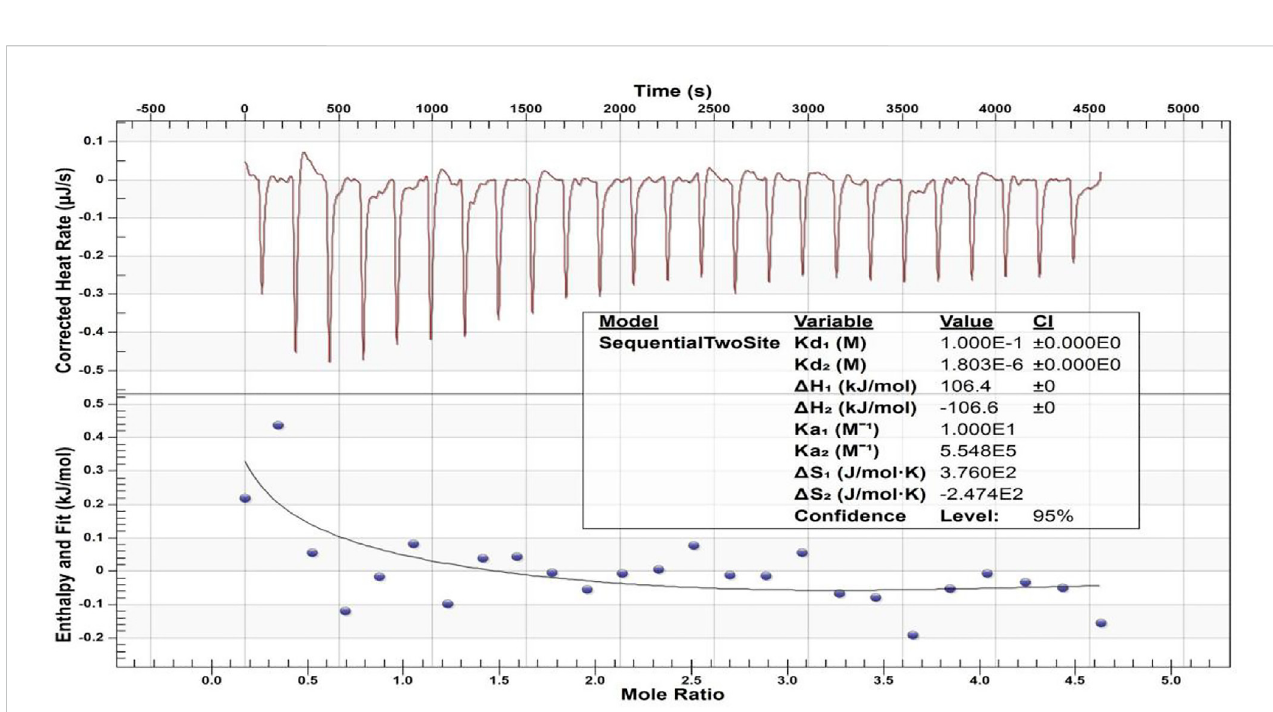
FIGURE 9 ITC-based Ca 2+ binding study of peptide 2. The top panel displays the raw titration data measured, and the bottom graph provides integrated heat data following corrections of dilution heat against molar ratio of Ca 2+ /peptide 2.